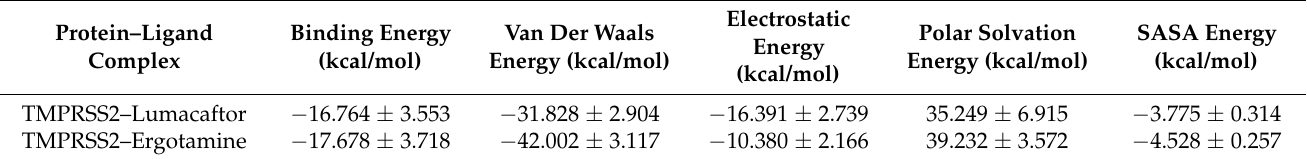
Table 1. Binding free energy of TMPRSS2 with lumacaftor and ergotamine based on calculations using the MM-PBSA